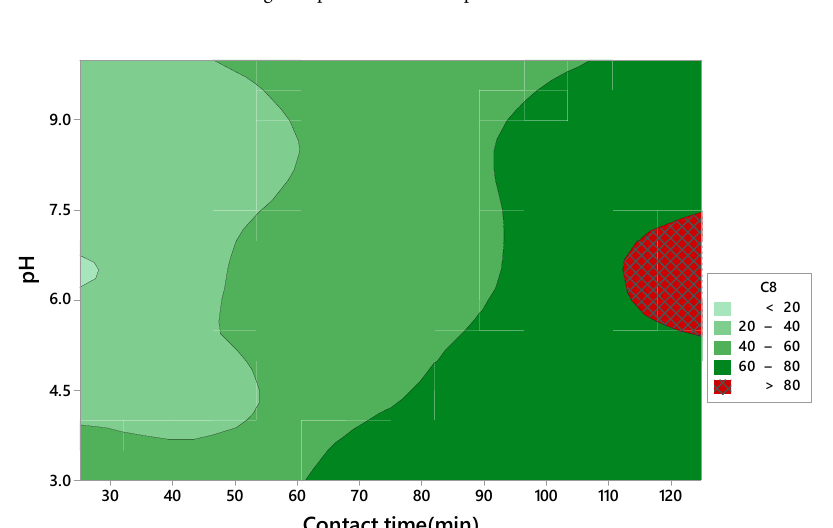
Fig. 5. Effect of pH on degradation of Acid Red 18 using TiO